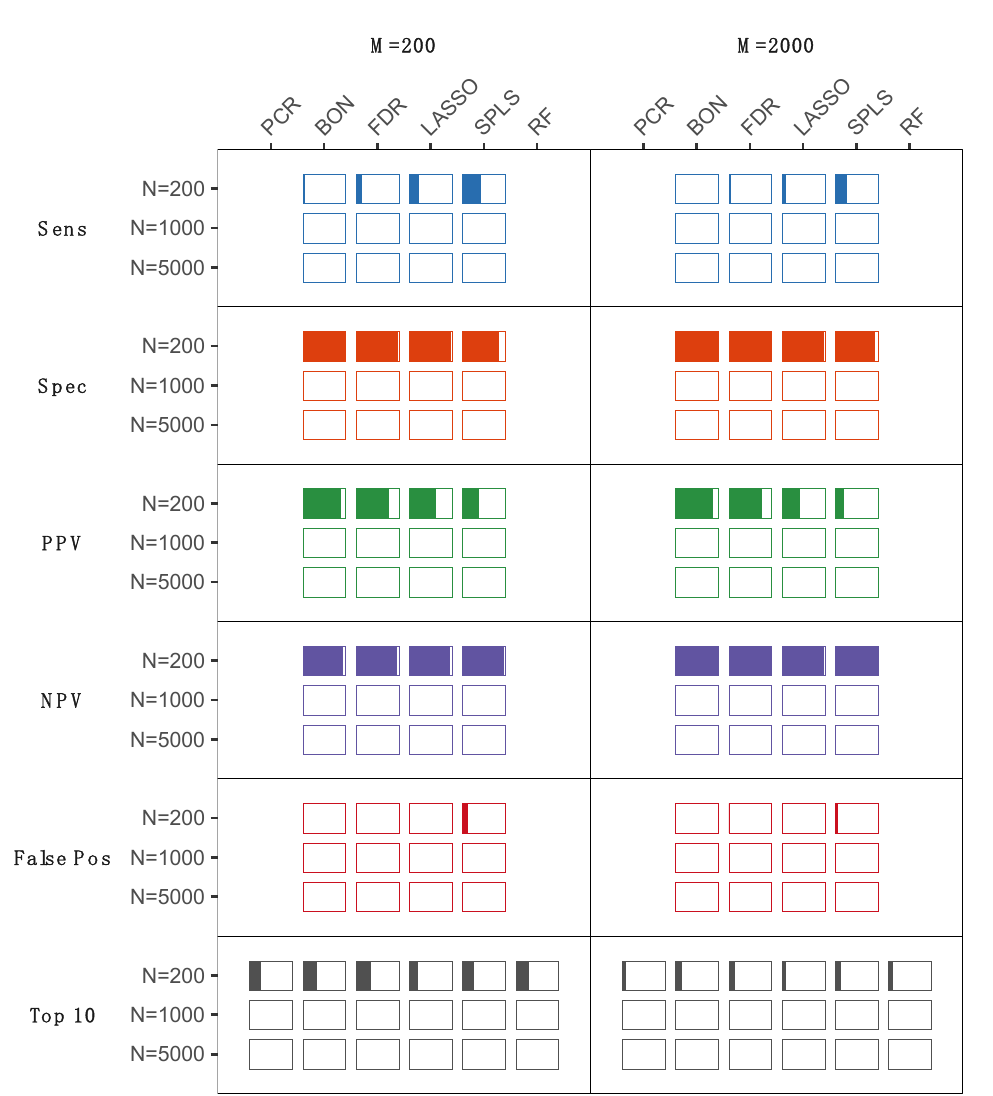
Figure 2. Results for a binary outcome. The sensitivity, specificity, positive predictive value (PPV), negative predictive value (PPV), and false positive rate are displayed (as percent color fill of each bar) for each statistical method, reflecting their ability to correctly identify the top ten simulated metabolite associations across varying numbers of total metabolite measures (M = 200 or M = 2000) in study samples collected from varying numbers of subjects (N = 200, N = 1000, or N = 5000). PCR, principal components regression; BON, Bonferroni; FDR, false discovery rate; LASSO, lease absolute shrinkage and selection operator; SPLS, sparse partial least squares; RF, random forests.